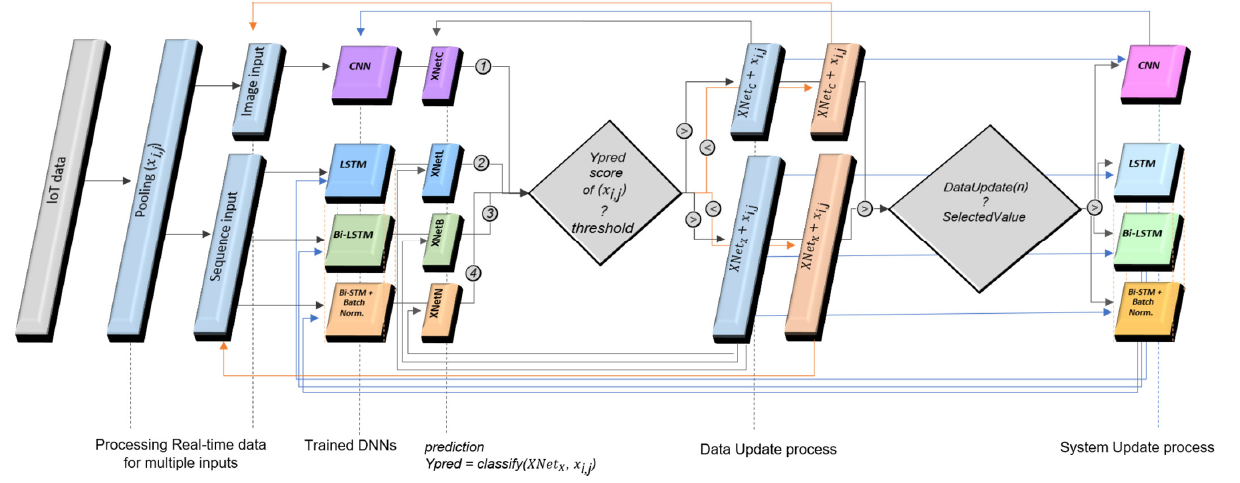
Figure 9. Model structure of real-time updating learning system, with deep neural networks ordered in the multilayered-tandem configuration. Table 9. Exemplar results of the Real-Time Learning